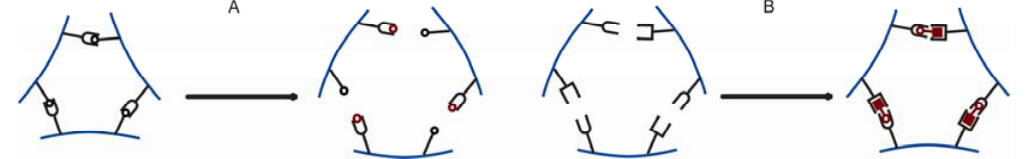
Figure 5. Schematic representations of swelling or shrinking mechanisms for the antigen sensitive hydrogels (a) antigen-antibody crosslinks dissociating in the presence of free antigen [55-57], (b) lectin-glycoprotein-antibody crosslinks formation in the presence of glycoprotein